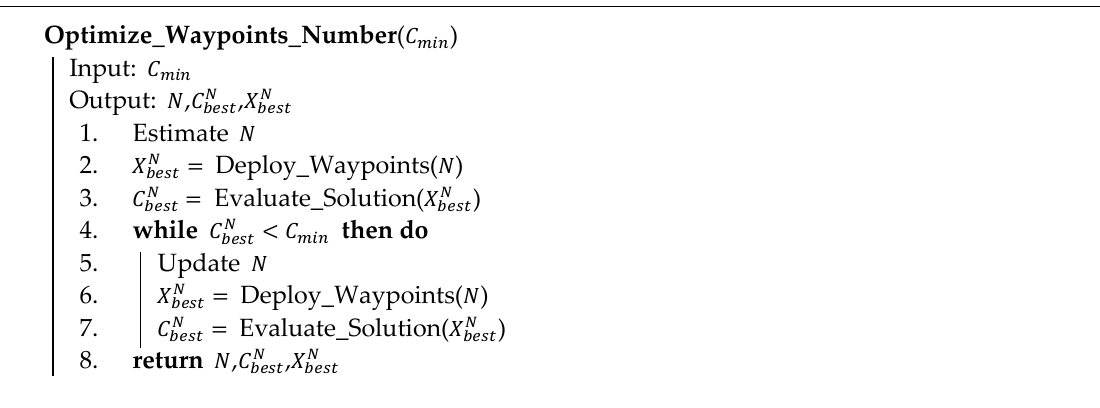
Algorithm 6 Optimizing the number of waypoints in pseudocode